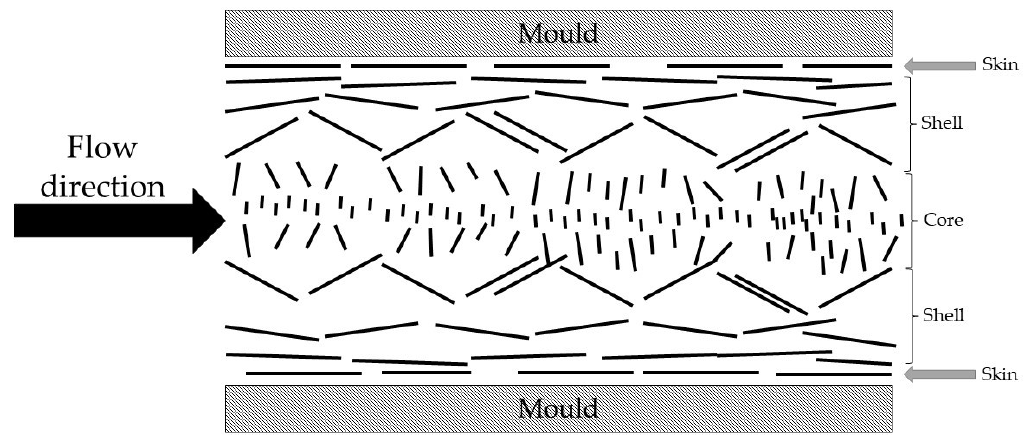
Figure 10. Scheme of fibers orientation inside the composite during injection molding.